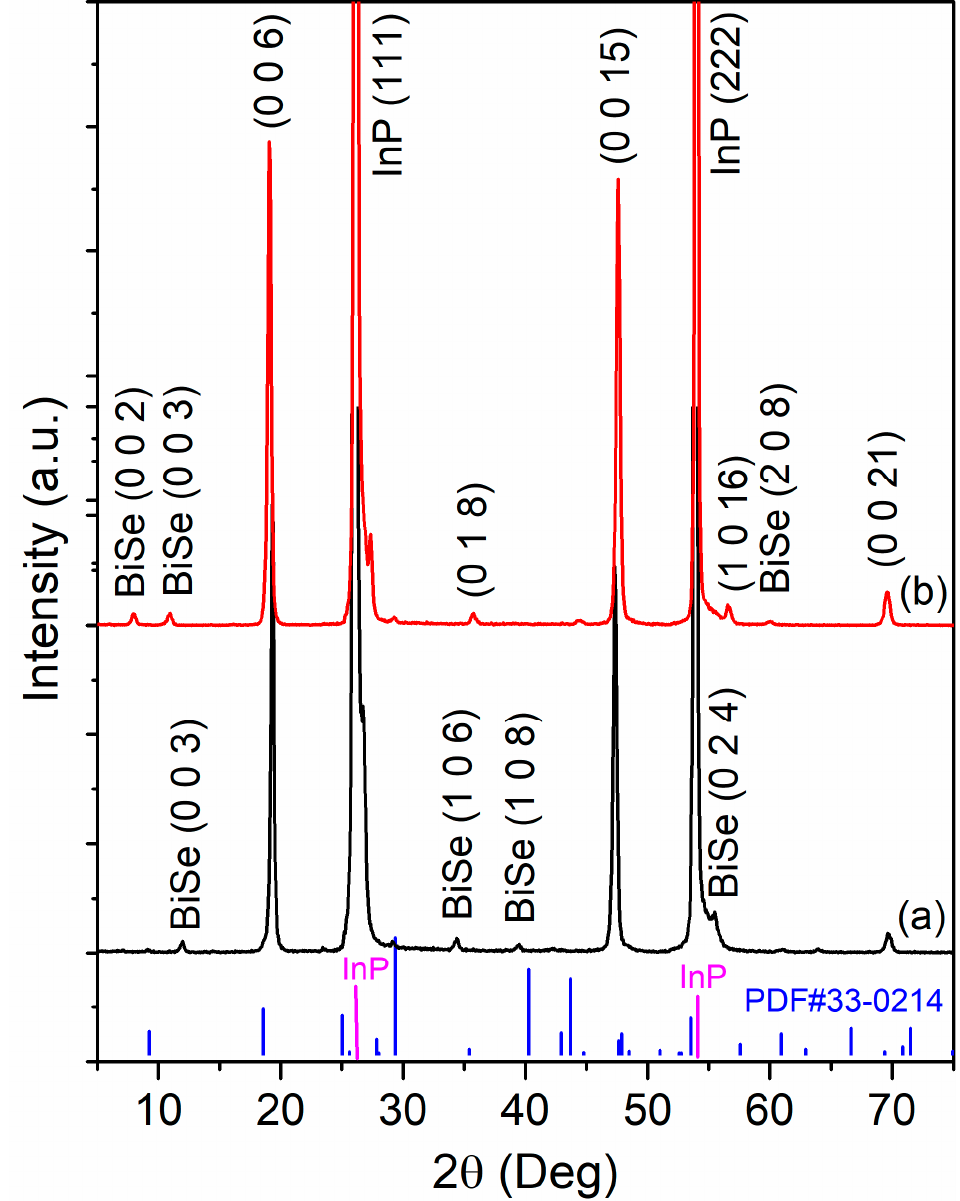
Figure 1. XRD patterns of Bi 2 Se 3 thin films grown on InP (111) substrates from two different targets of Bi 2 Se 3 ( a ) and Bi 2 Se 5 ( b ) using pulsed laser deposition.